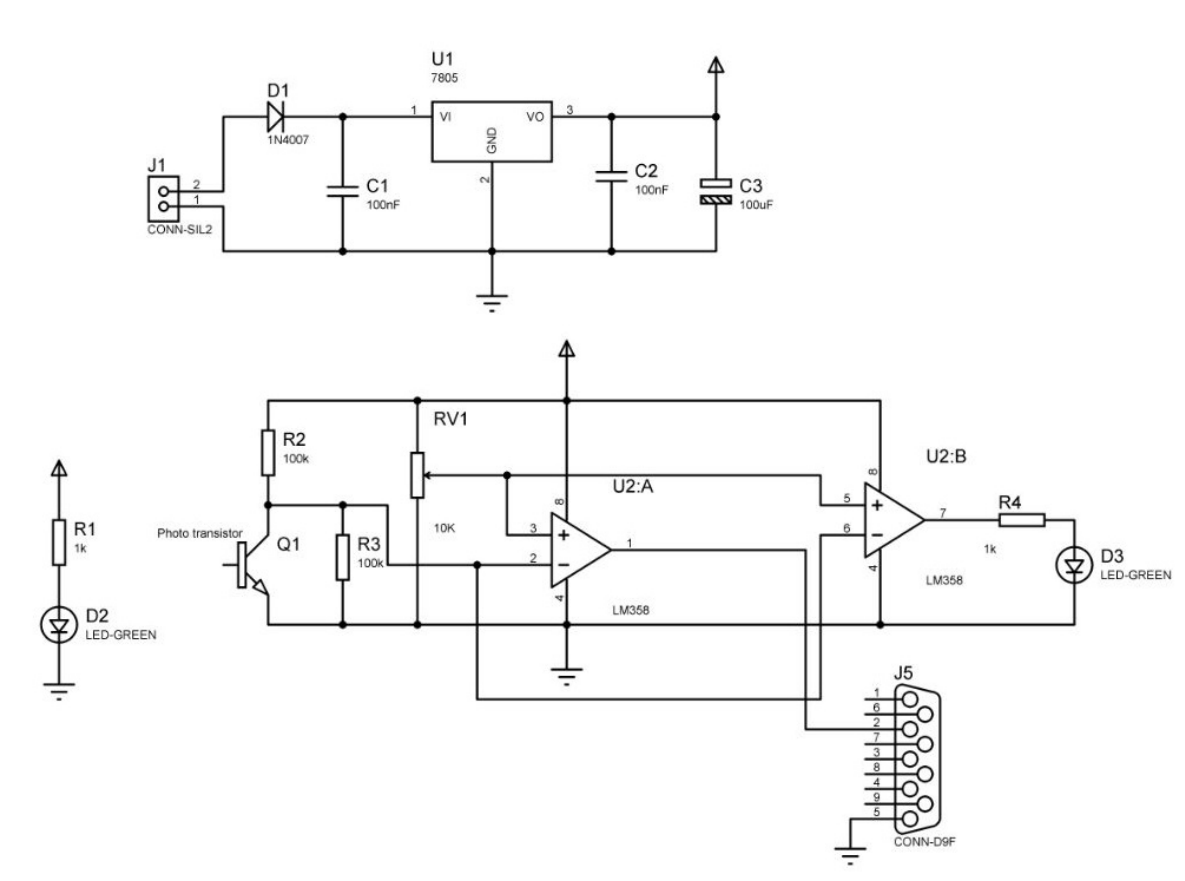
Figure 10. VLC receiver design for hardware